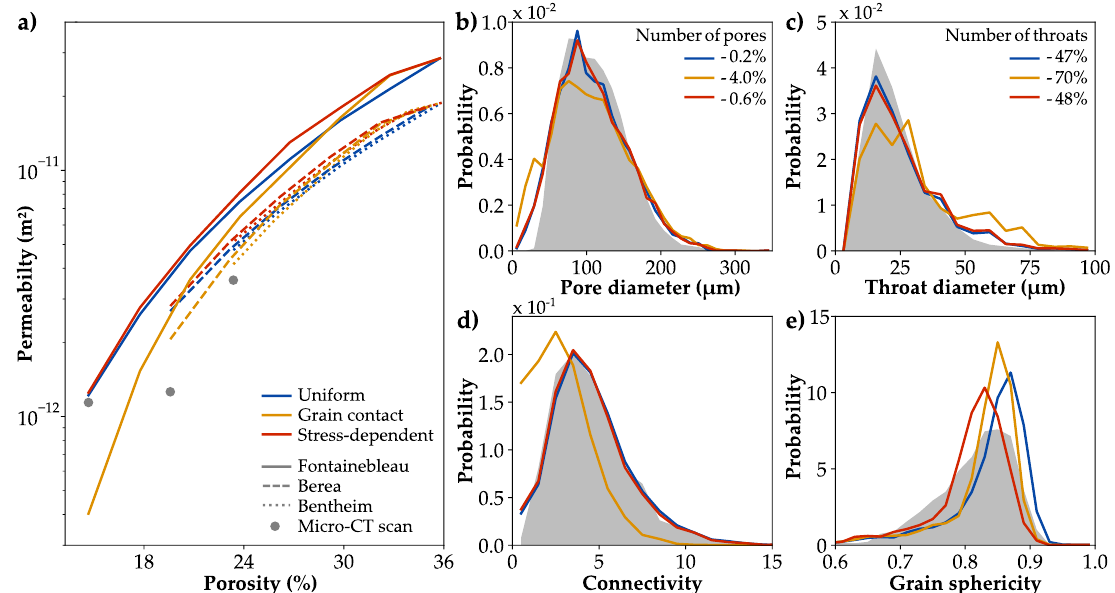
Figure 7. Evolution of hydraulic and related geometric properties for the three synthetic samples cemented by the uniform (blue), contact-preferential (orange) and stress-dependent scheme (red). ( a ) Diagenetic trends in permeability for the three investigated sandstones. ( b ) Pore and ( c ) throat diameters, ( d ) connectivities as well as ( e ) grains sphericities for the three cementation scenarios (coloured lines), and the micro-CT scan of the Fontainebleau sandstone (grey-filled) at a porosity of